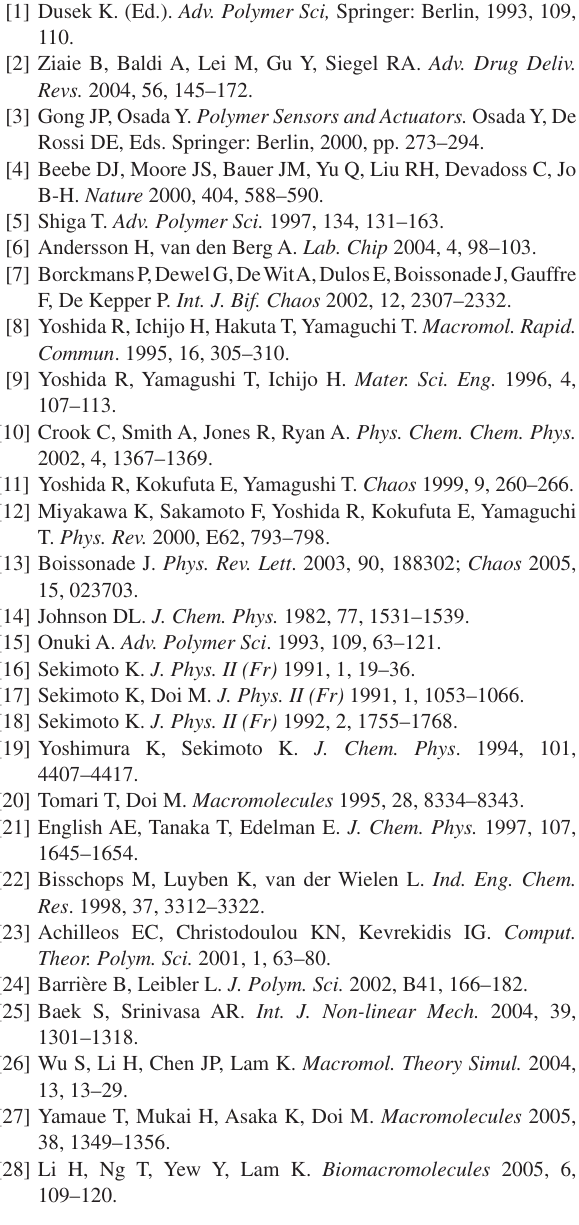
Figure 9 Profi le of φ , the polymer volume fraction during p SWELLING for the sequence (1–5) defi ned in Figures 5 and 7.